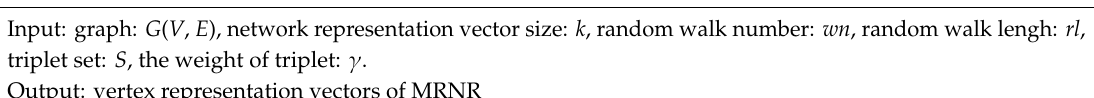
Algorithm 1: MRNR